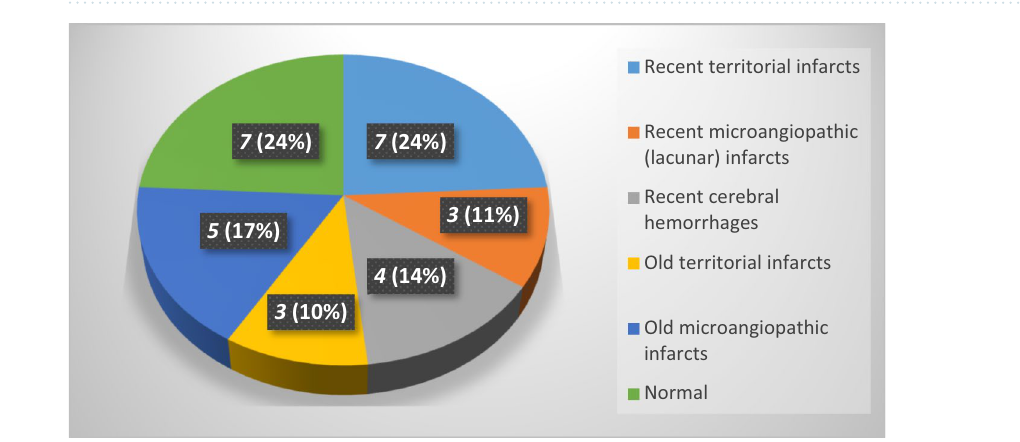
Figure 4. The distribution of patients, revealing brain MRI findings, in RT-PCR proved SARS-CoV-2 pneumonia, and presented with focal neurological